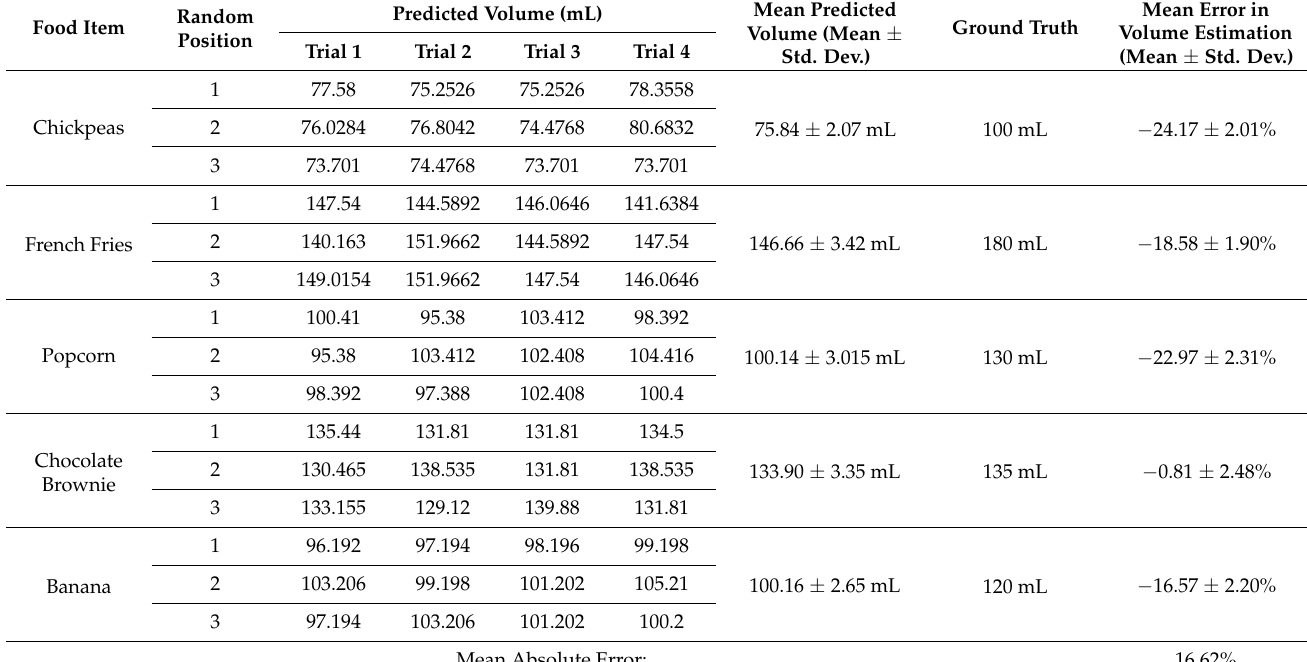
Table 3. Errors in volume estimation using the Pico Flexx cam.